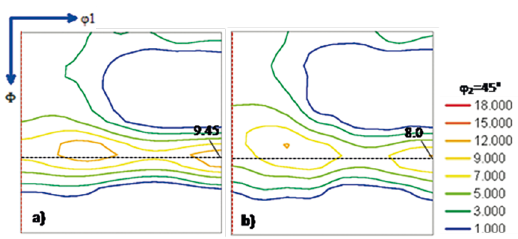
Figure 6. Macro-texture after 50% cold rolling: a) near the surface after the second reduction; b) center after the second reduction; ϕ =45° ODF section. 2